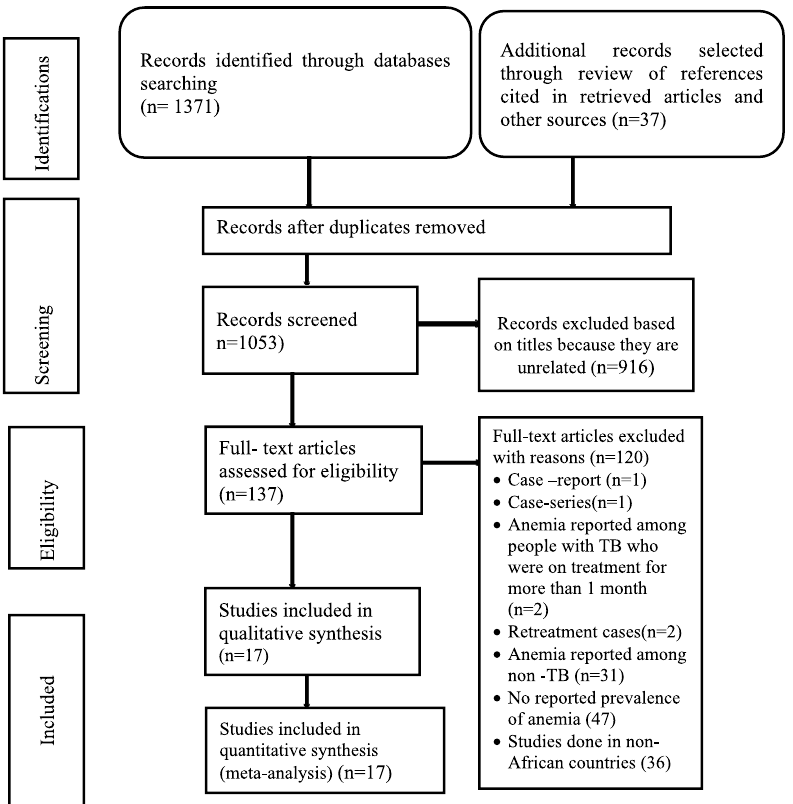
Figure 1. Preferred reporting items for systematic reviews and meta-analyses (PRISMA) 26 flow diagram indicating the selection of studies for the systematic review and